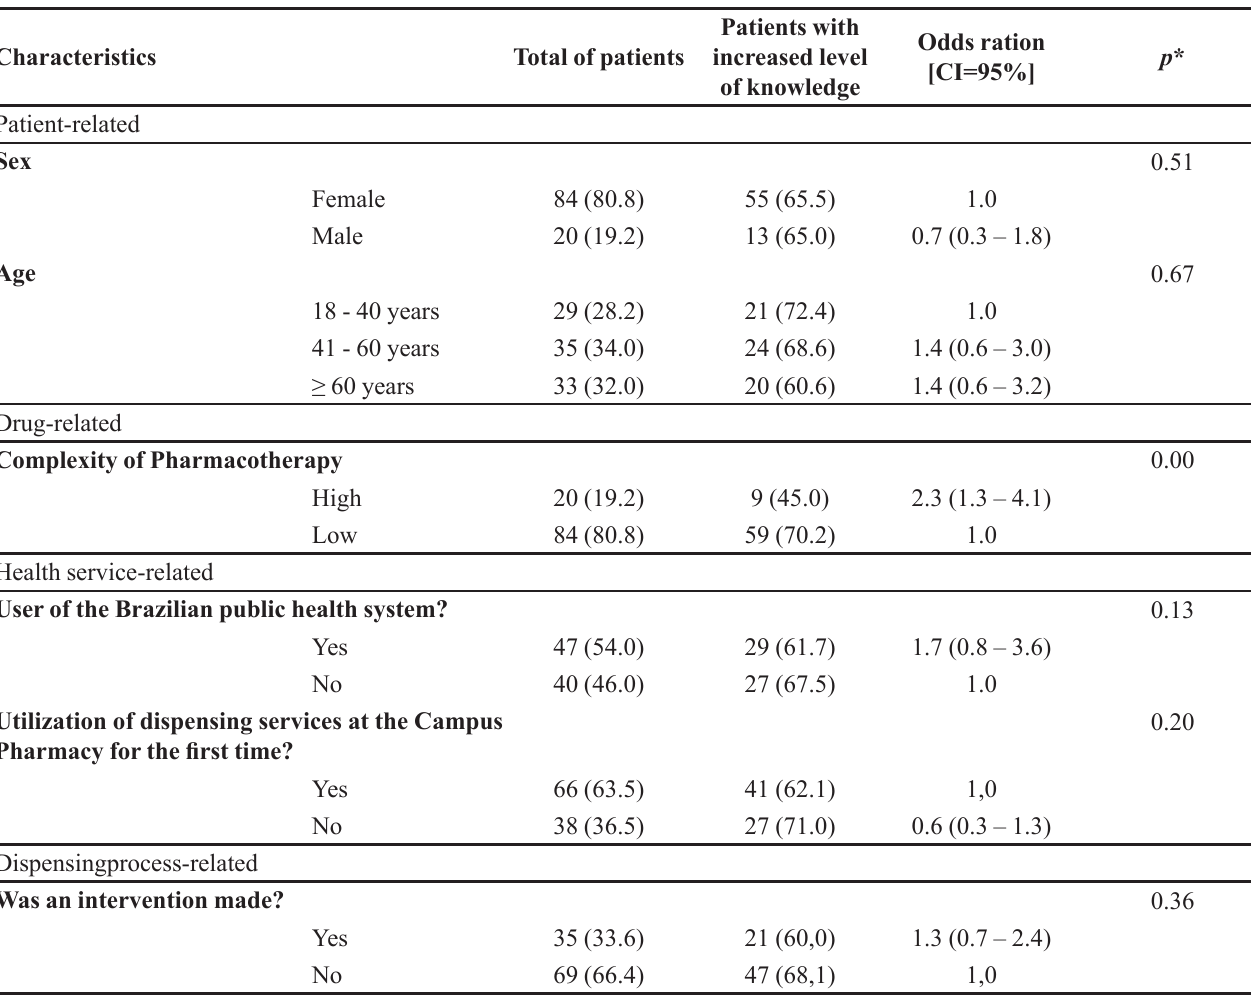
TABLE V - Factors associated with the increase in the level of patient knowledge about medication during the dispensing process at the Campus Pharmacy, Goias, Brazil, 2013